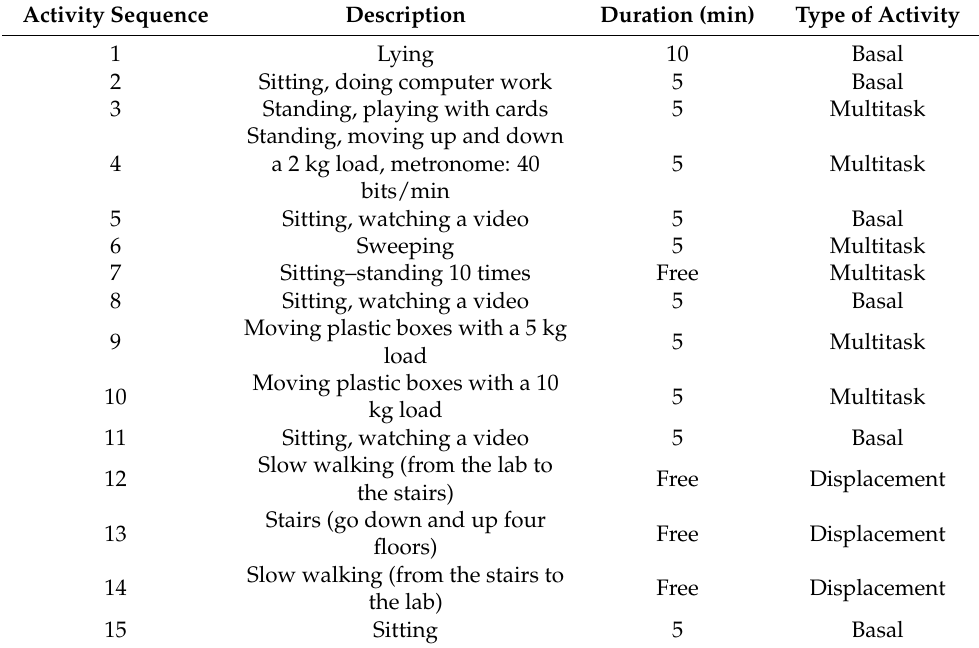
Table 2. Detailed description of protocol of activities.